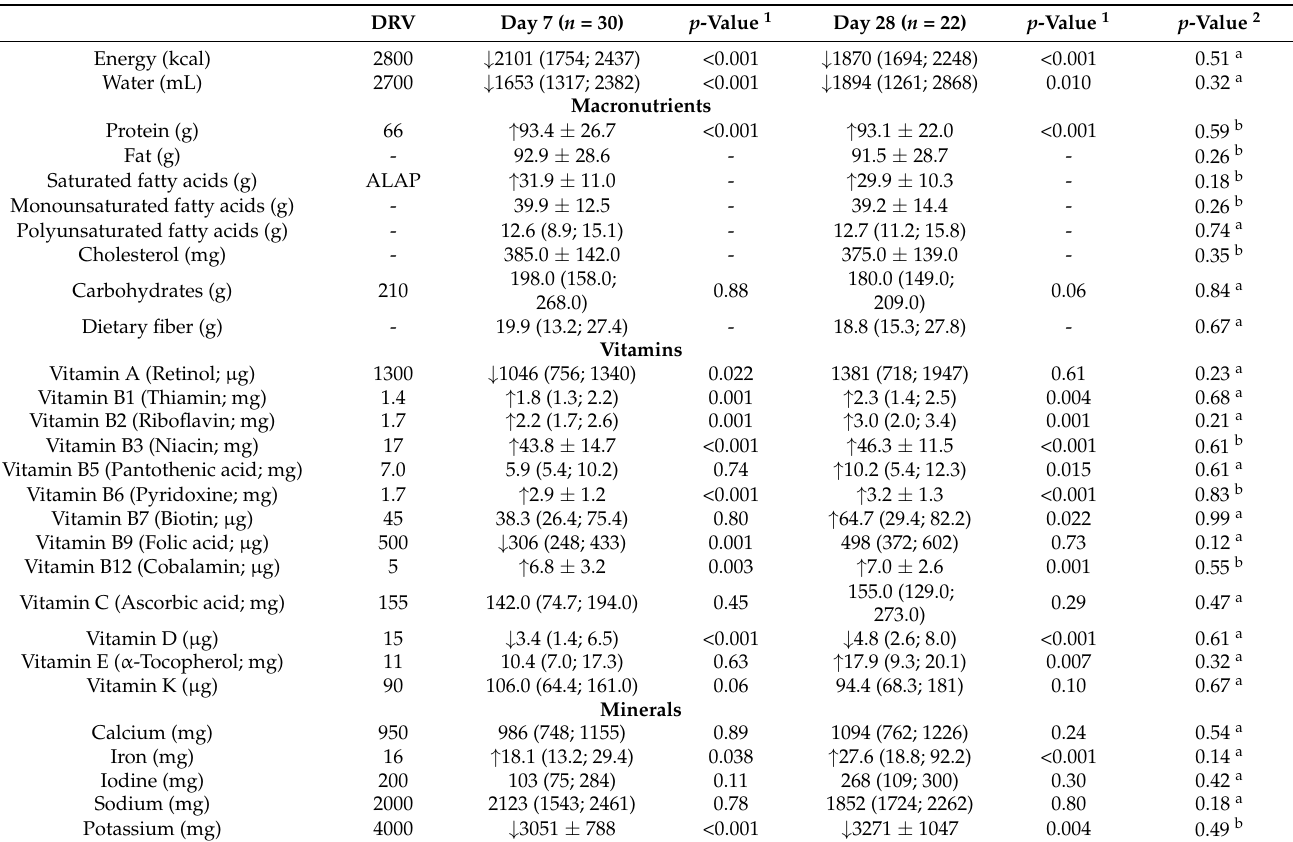
Table 1. Maternal nutrients consumption on days 7 and 28 postpartum and comparison with recommended